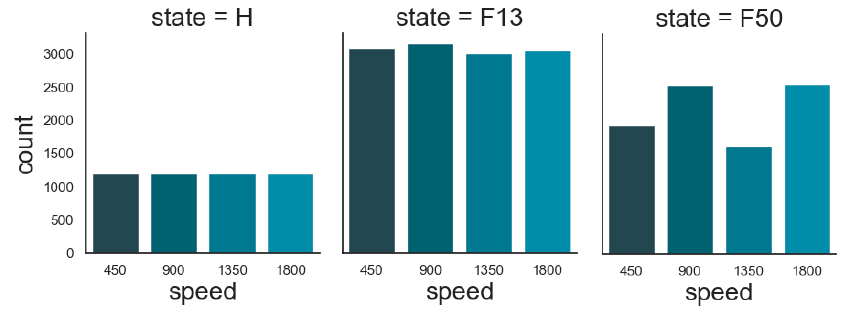
Figure 5. Counts of Speed cases’ function of state.